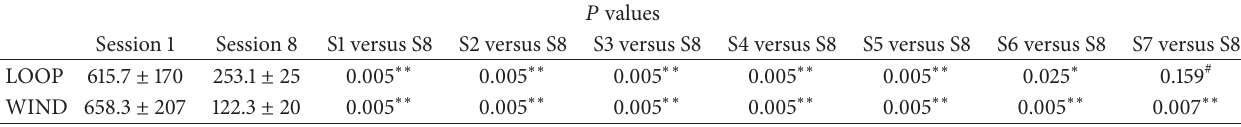
Table 6: Comparison of statistical significance for every session in both groups. 𝑃